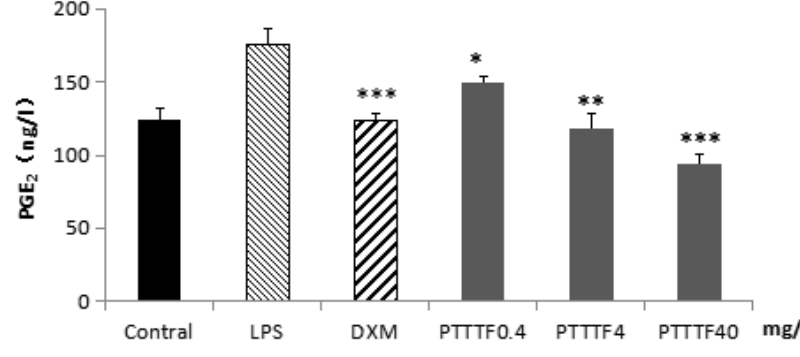
in LPS-induced RAW264.7 cells ( n =3) 2